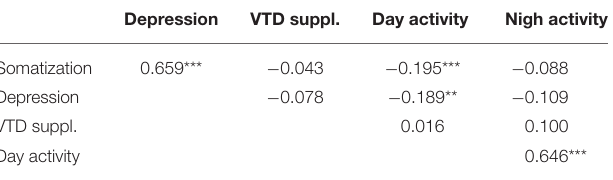
TABLE 3 | Correlations for all the main variables of the study. Depression VTD suppl.